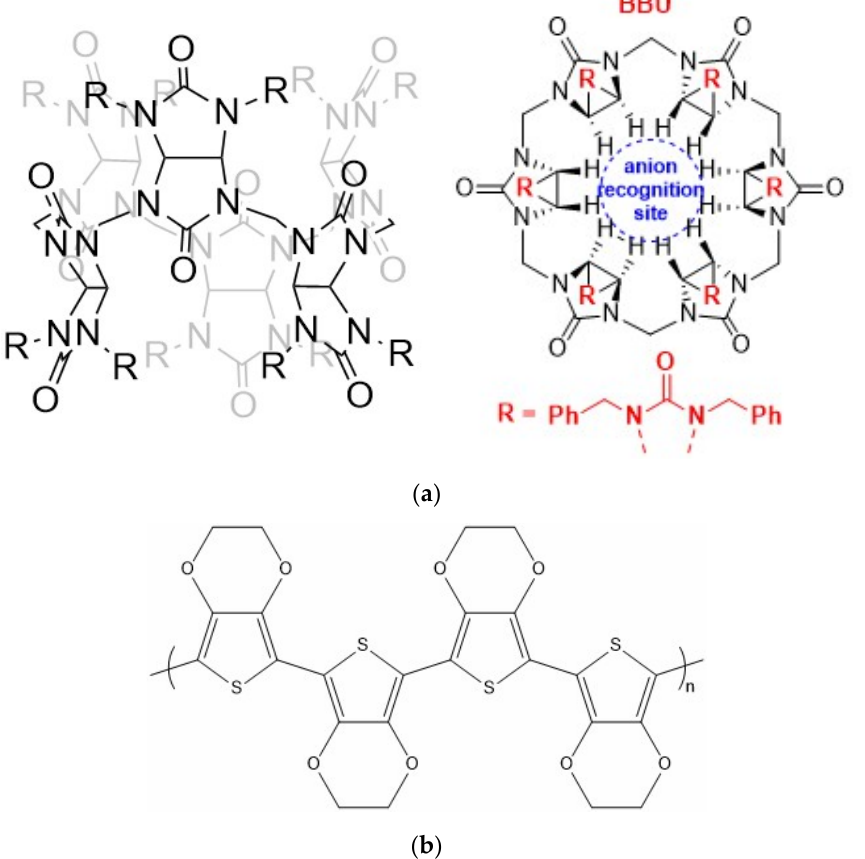
Figure 1. The chemical structure of dodecabenzylbambus[6]uril (Bn 12 BU[6] = ionophore) ( a ) and poly(3,4-ethylenedioxythiophene) (PEDOT, conjugated polymer in its undoped form) ( b ).